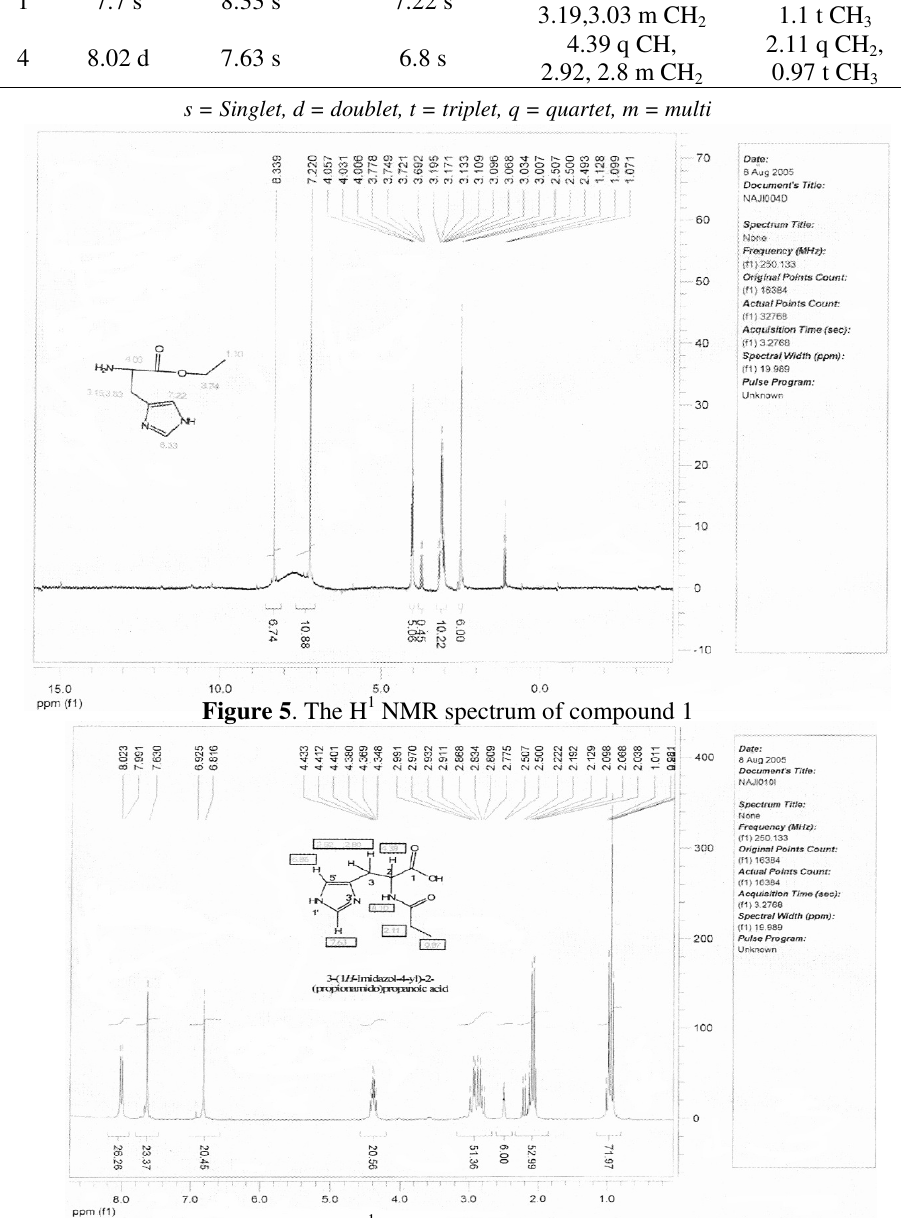
Figure 6 . The H 1 NMR spectrum of compound